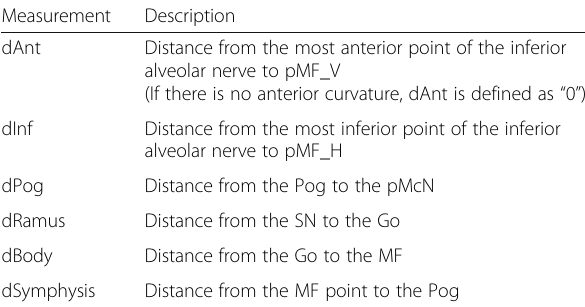
Table 2 Distance measurements of loop of the inferior alveolar nerve and the mandibular functional units Measurement Description